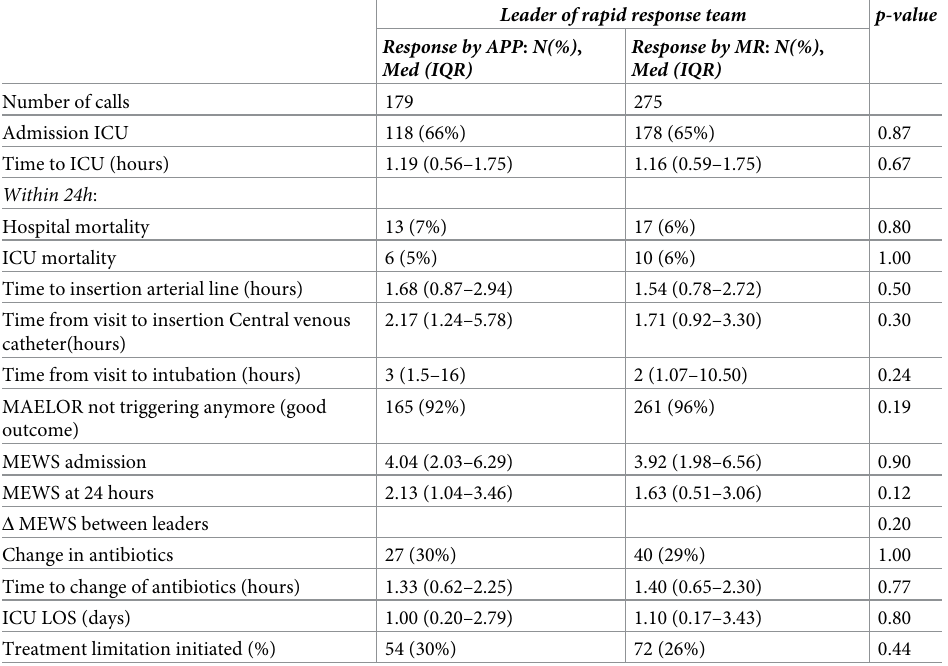
Table 2. Outcome